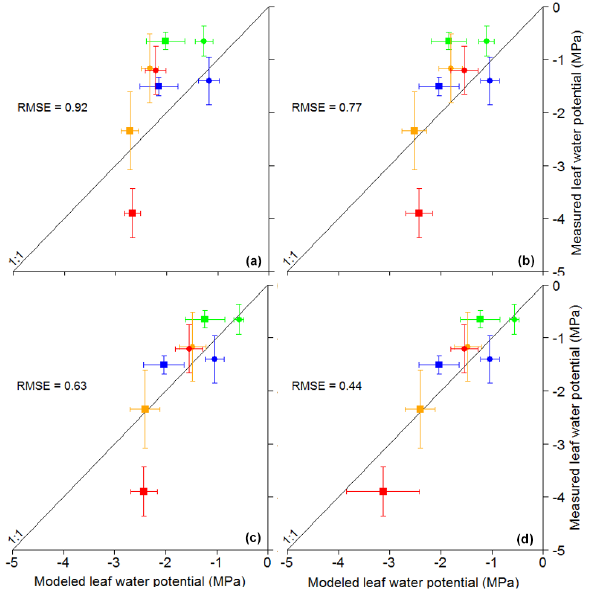
Figure 12. Simulated vs. observed individual-level variation in midday leaf water potential, Caxiuana National Forest, Brazil. (a) Without accounting for xylem taper and using mean plot val- ues for input plant traits and derived hydraulic traits from Table 2 (Savage et al., 2010, taper exponent p = 0 . 0, LMA = 96.1gm − 2 , WD = 0.73gcm − 3 , N L = 20 . 9mgg − 1 , P L = 0 . 59mgg − 1 ) . (b) As in panel (a) but accounting for xylem taper ( p = 1 / 3). (c) As in panel (b) but after modifying canopy position of individual trees (see Methods). Panel (d) as in panel (c) but forcing tree C3 to be less isohydric by setting P 50,gs = − 5 . 0MPa ( P 50 , x remained the same at − 3.2MPa). Different colors represent the following four individ- uals from Fisher et al. (2006): green – tree C2 (18.7cm DBH), blue – tree C1 (15.6cm DBH), orange – tree C4 (43.9cm DBH), and red – tree C3 (51.5cm DBH). Filled circles and squares represent wet and dry season values,